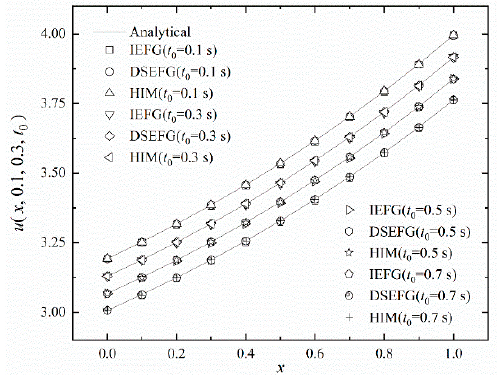
Figure 9. Calculation results along x -axis when t